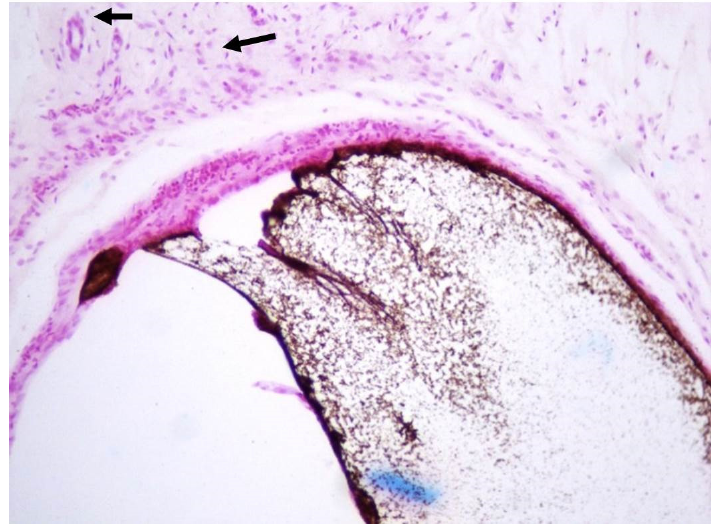
Figure 5. Histologic micrograph of foreign material surrounded by a thin fibrous connective tissue capsule. The matrix contained mild inflammatory cell infiltrate composed primarily of lymphocytes and few scattered small blood vessels (arrows). H&E: hematoxylin & eosin stain, ×200.